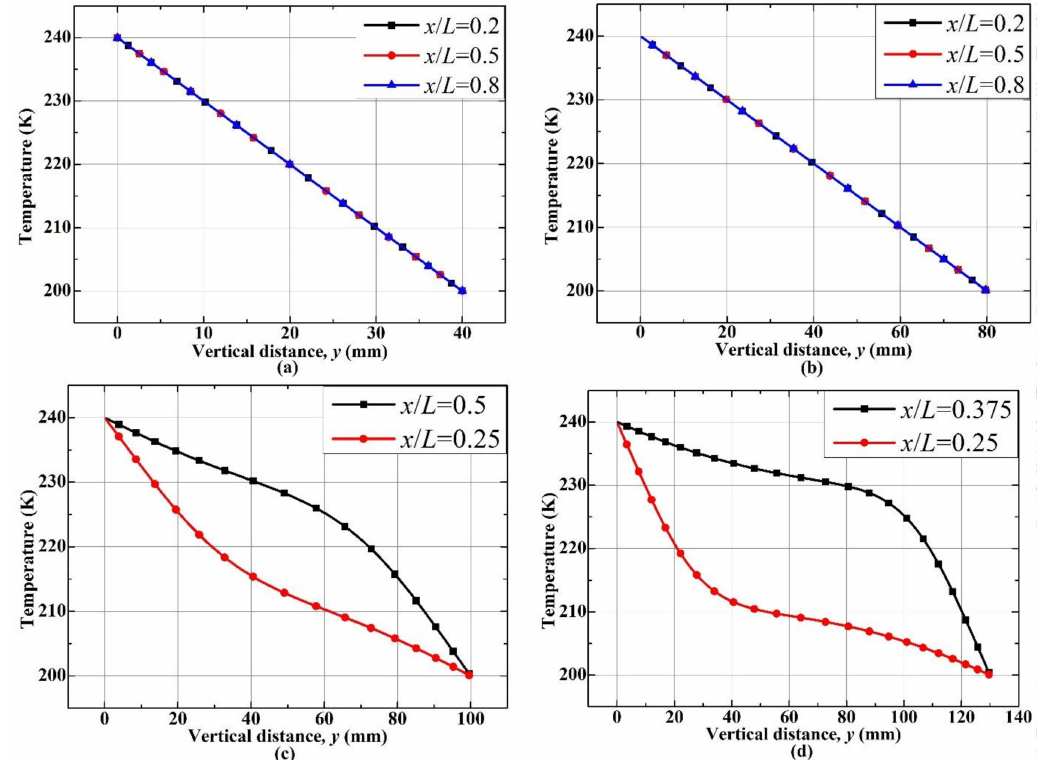
Figure 7. Variation in the horizontal enclosure temperatures with vertical distance at L = 1000 mm, ∆ T = 40 K: ( a ) H = 40 mm; ( b ) H = 80 mm; ( c ) H = 100 mm; ( d ) H = 130